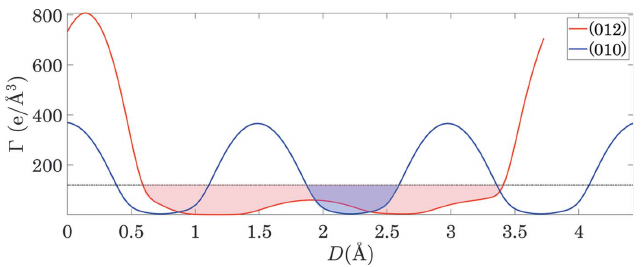
Figure 20 (cid:2) (012, D ) and (cid:2) (010, D ) curves for LiNbO 3 . The horizontal dashed line is drawn at the chosen threshold level of 0.75 (cid:2) 0 .